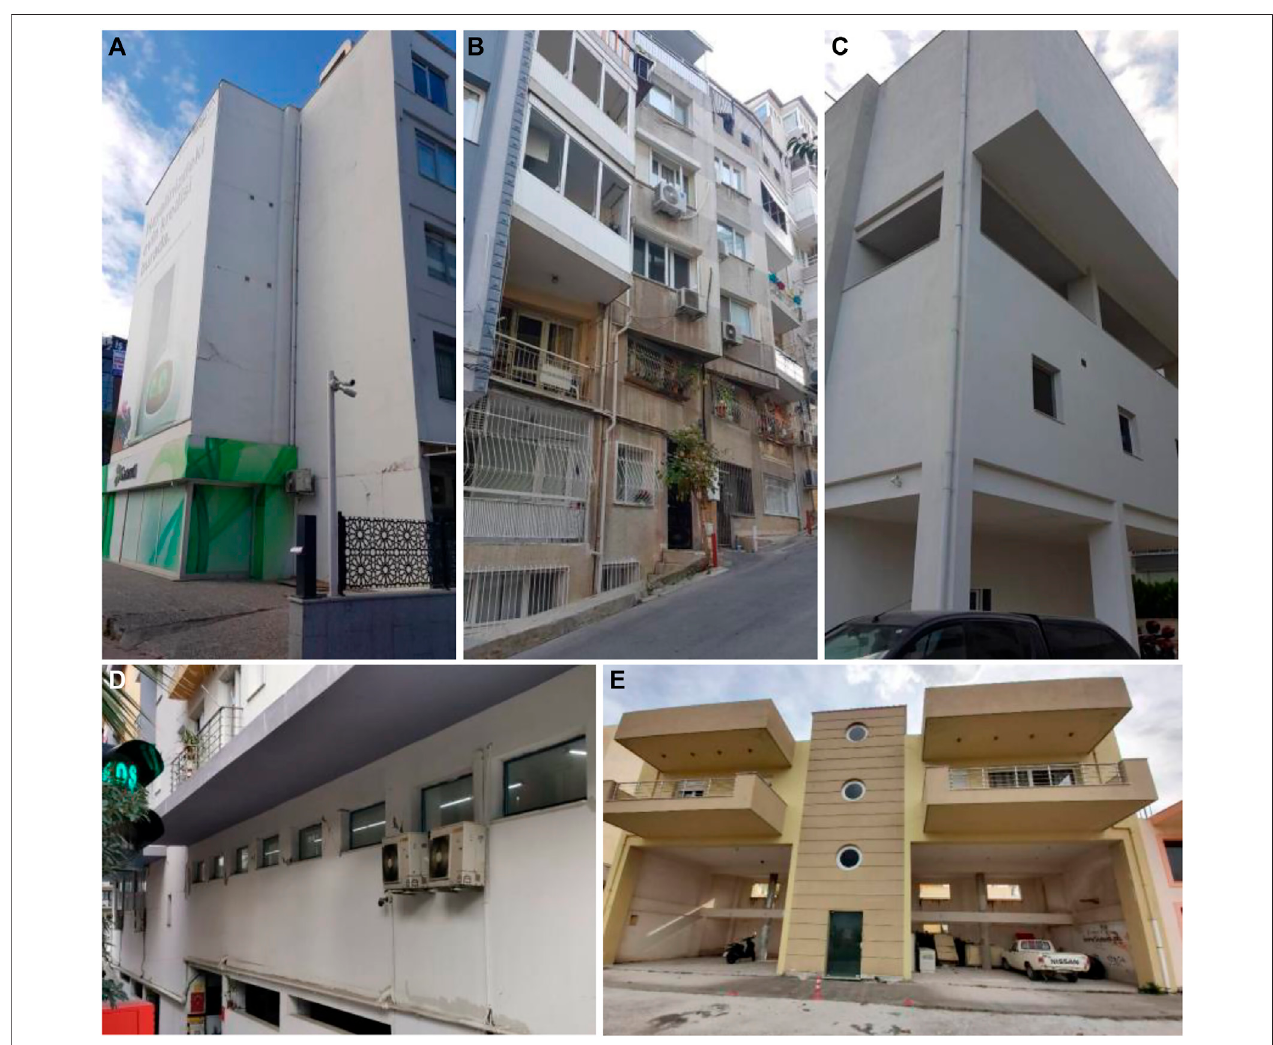
FIGURE12| ExamplesofcommonirregularitiesinRCbuildings[ (A) :Changesinstiffnessduetostructuresattachedtothemainbuilding, (B,C) :Elevationandplan irregularities, (D) : short columns, (E) : plan and elevation irregularity, and large openings at the ground fl oor].